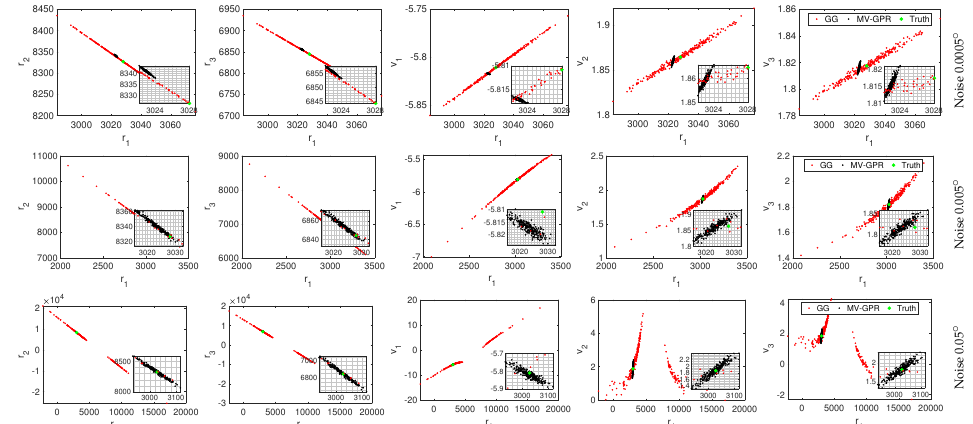
Figure 16. Qualitative study of Orbit C at various noise levels. The black points are MV-GPR and the red are Gauss–Gibbs predictions,while the green point represents the